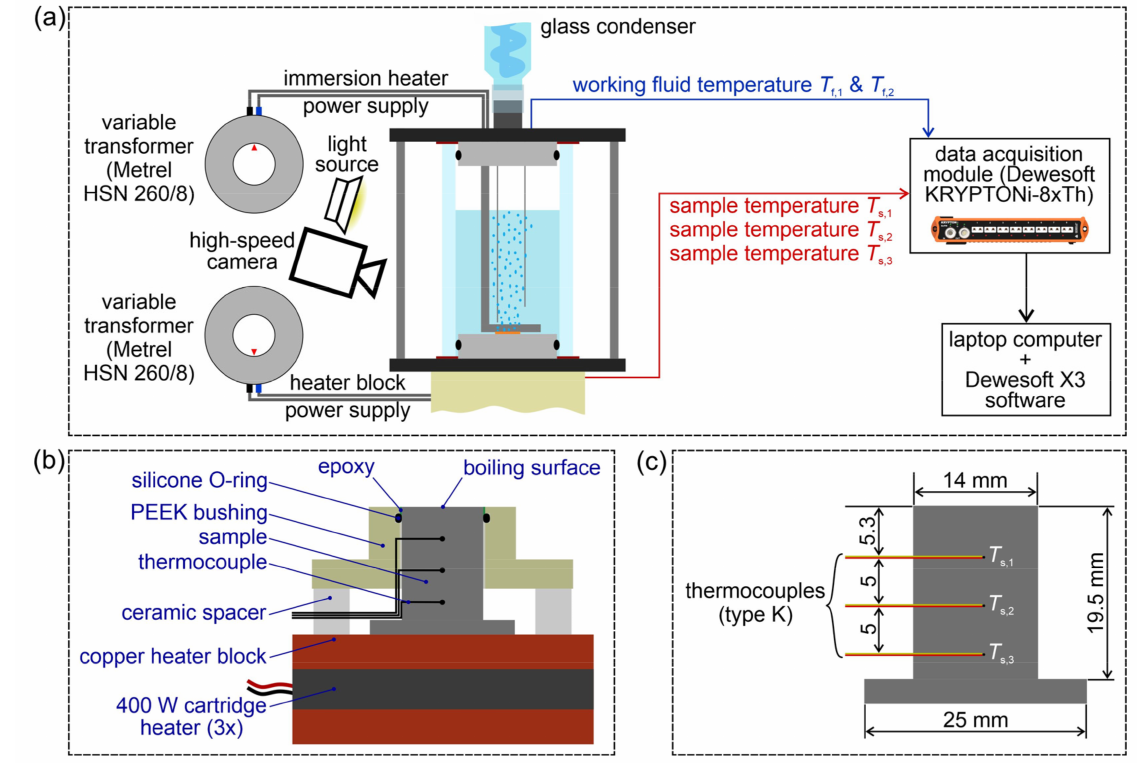
Figure 1. Schematic diagram of the pool boiling experimental setup ( a ), cross section of the sample and the heating block ( b ) and dimensions of the sample including the placement of thermocouples ( c